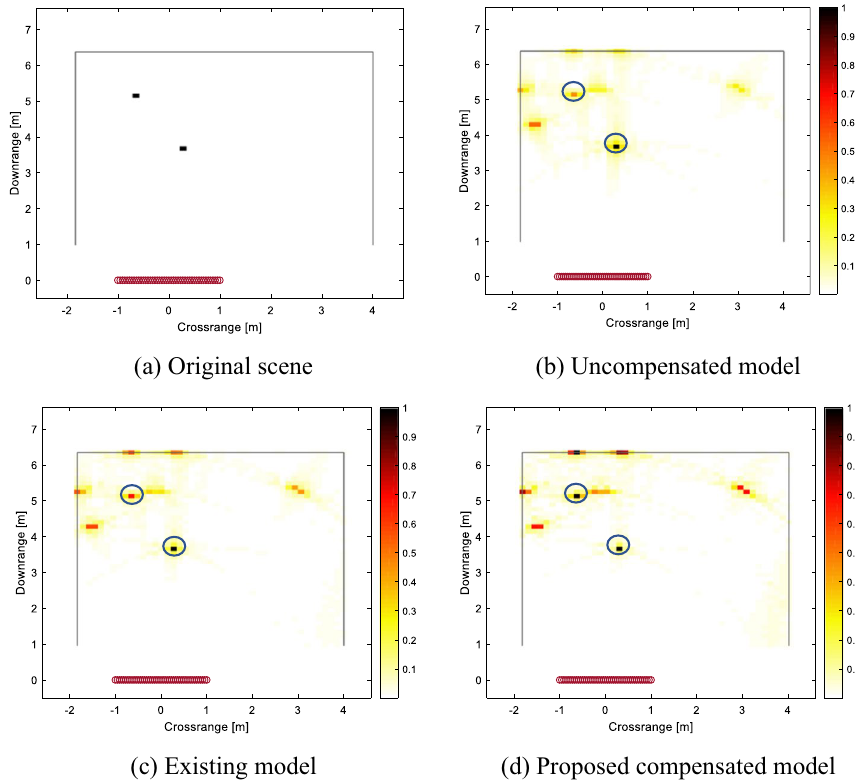
Fig. 4 Images from Delay-and-Sum Beamforming in two targets scenario